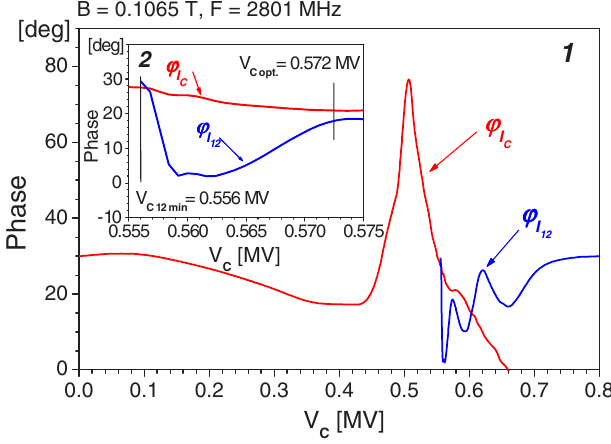
FIG. 3. (Color) Phases of the loading current, ’ , as functions of the accelerating cavity extracted current, ’ I 12 voltage, V . C